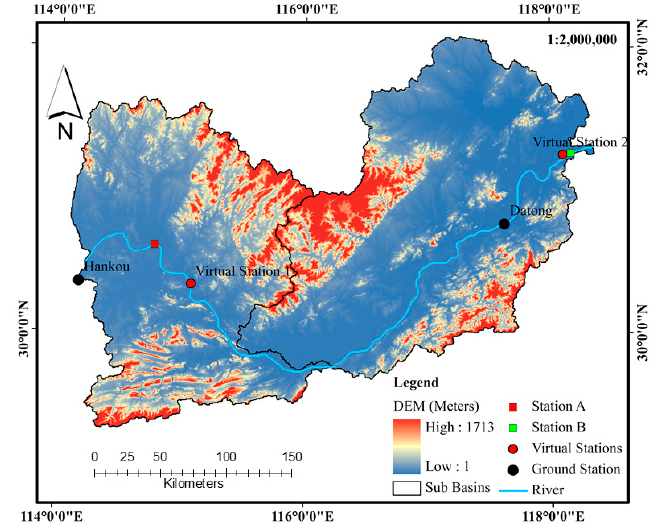
Figure 1. Locations of the ground observation stations, river width measurement stations A and B, and virtual stations 1 and 2 along the lower course of the Yangtze River.